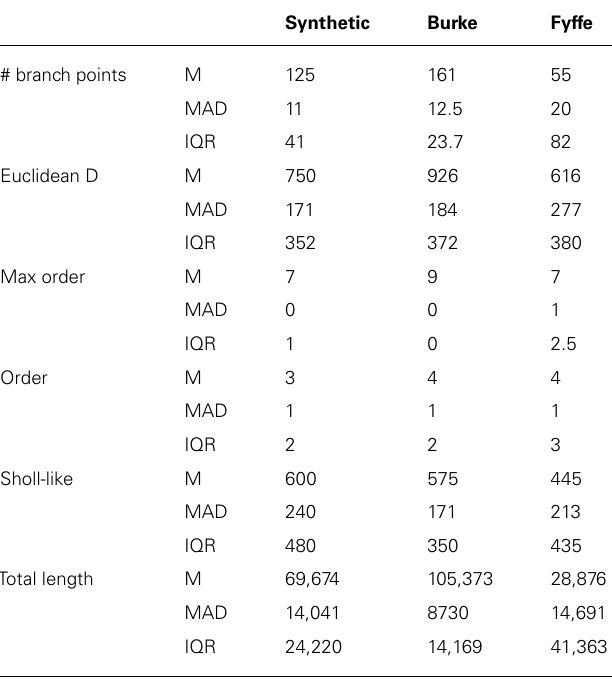
Table 3 | Quantification of generated and experimentally reconstructed alpha motor neurons. Synthetic